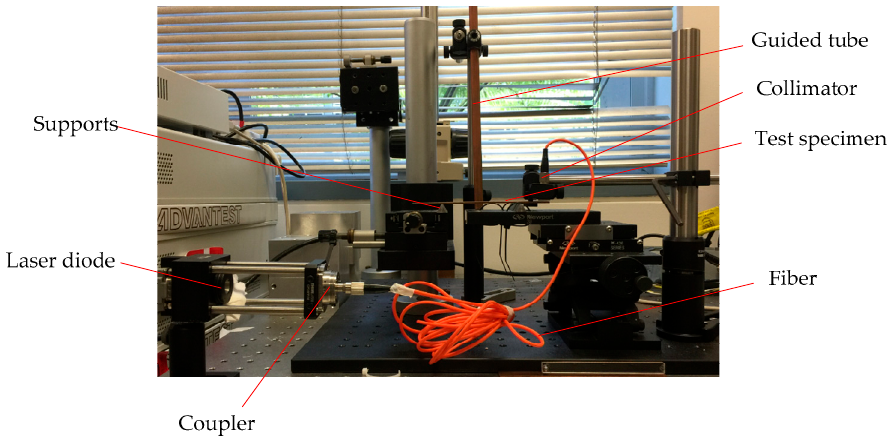
Figure 8. Experimental set-up of fiber-coupled SMLD.